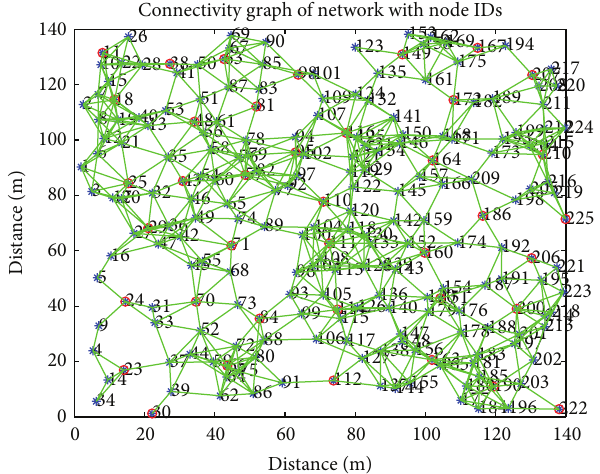
Figure 3: The network with connectivity 7% and 5% range error.